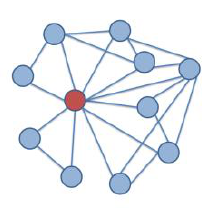
Figure 4. Degree Centrality Network Graph.